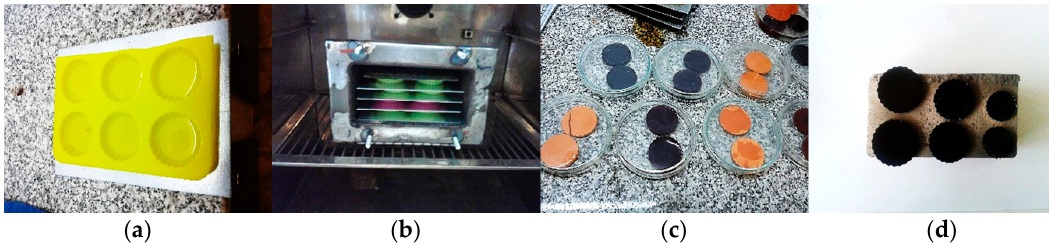
Figure 1. The experimental setup used for xerogel preparation: ( a ) silicon mould to keep all the disks in the same shape, ( b ) sealed chamber to avoid any solvent loss during the gelation process, ( c ) solvent exchange process, ( d ) different levels of shrinkage for carbon xerogels after pyrolysis.